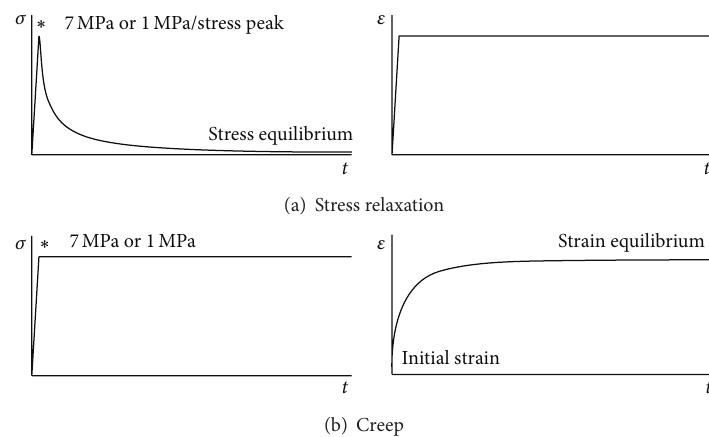
Figure 1: Schematic overview of the loading protocols used for stress relaxation and creep. Compression loading of either 7MPa or 1MPa was applied, indicated by the asterisks, followed by either (a) stress relaxation or (b) creep. For (a) stress relaxation, the position (strain) of the channel indenter was held constant while for (b) creep the load was held